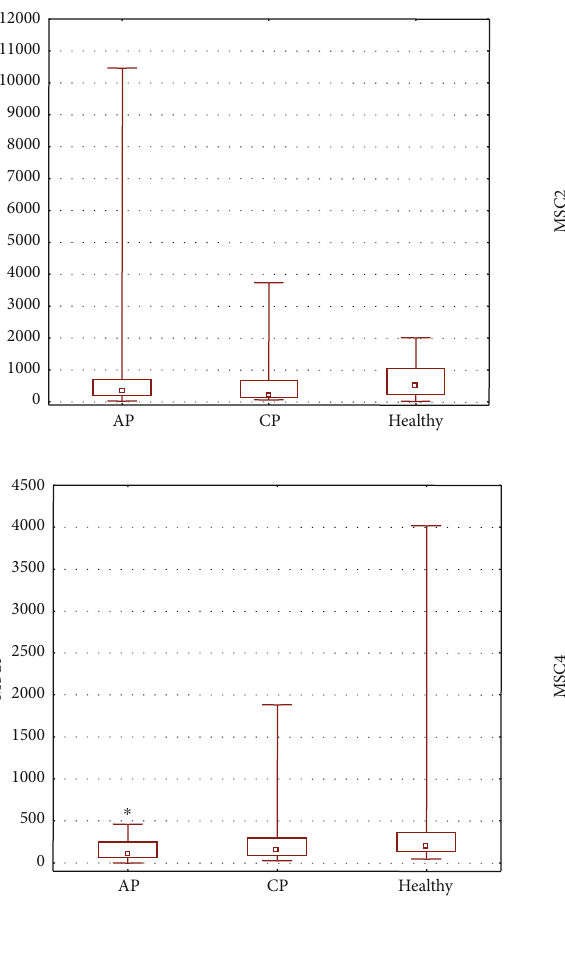
Figure 3: The absolute numbers of MSCs “ 1 ” , MSCs “ 2 ” , MSCs “ 3 ” , and MSCs “ 4 ” populations circulating in the peripheral blood of patients.